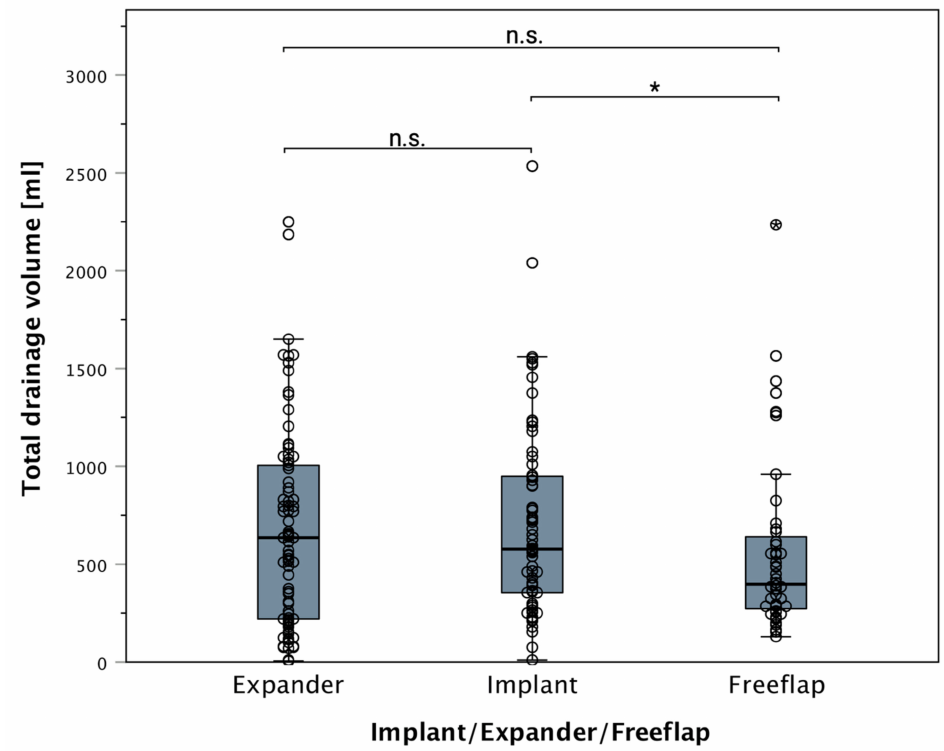
Figure 7. Boxplot of drainage fluid output between groups at reconstruction: a significant difference in the drainage fluid volume is present between definitive implant-based reconstructions and the free tissue flap group (in primary reconstruction) (* p = 0.045). This effect is not significant in secondary reconstructions without mastectomy. Only if patients were preoperatively anemic, a significant increase in drainage fluid output is seen at secondary reconstruction. Implicating anemia as being the cause of elevated drainage fluid output (regardless of reconstruction modality). “n.s.” indicating no significance. The star (*) indicating a statistically significant difference between the groups ( p < 0.05). All data points (including outliers) can be seen incorporated as scattered